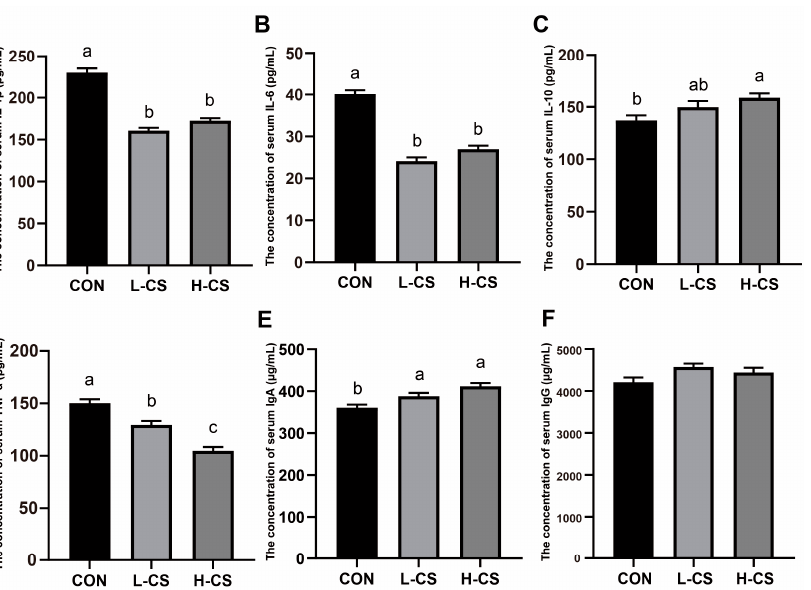
Figure 3. The effects of chitosan on the levels of inflammatory cytokines and immunoglobulins in the serum of cats: ( A ) Interleukin (IL)-1 β ; ( B ) IL-6; ( C ) IL-10; ( D ) Tumor necrosis factor (TNF)- α ; ( E ) Immunoglobulin A (IgA); ( F ) Immunoglobulin G (IgG). Note: CON represents basic diet; L-CS, basic diet containing 500 mg/kg chitosan; H-CS, basic diet containing 2000 mg/kg chitosan; and SEM, standard error of means. Values are presented as means ± SEMs, n = 10. Different letters on the top of the column represent significant differences ( p < 0.05).